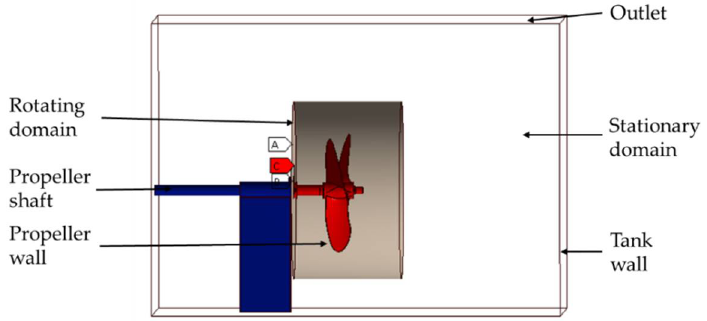
Figure 5. Computational domains with boundary conditions.